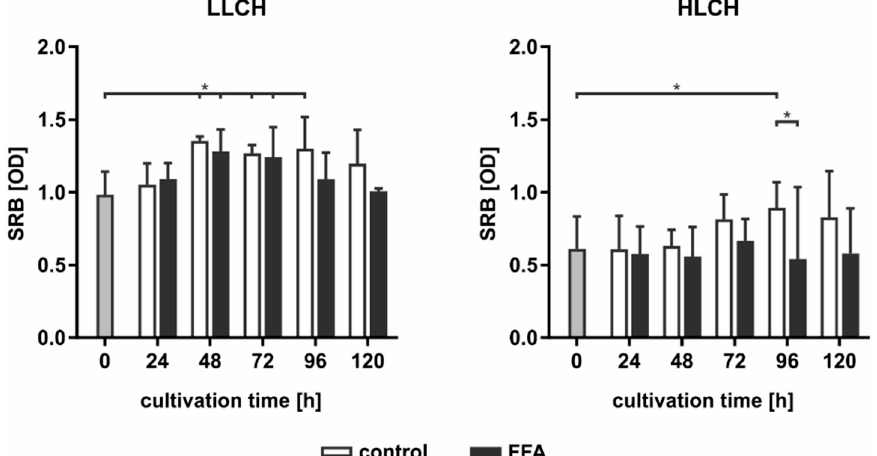
Figure 7. PERK activation leads to the inhibition of protein expression on the cell surface. In the LLCH (donors 1–3) and HLCH (donors 4–6), the amount of surface proteins was measured using SRB staining. Data are shown as the means ± SD, n = 3, two-way ANOVA, and post hoc Dunnett or Bonferroni analysis. A p value of 0.05 or less (*) was considered significant. For the details on the statistical evaluation, see Table S1G.